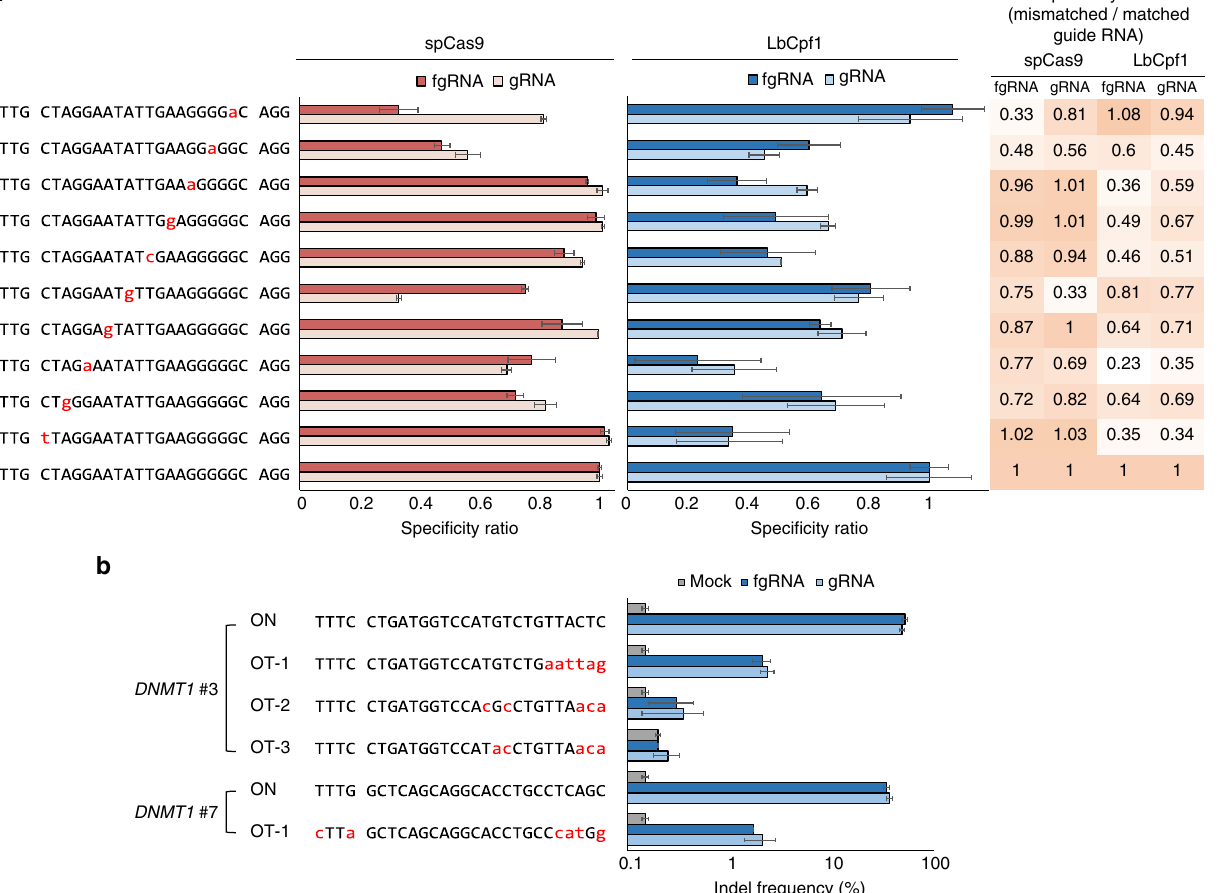
Fig. 2 Comparison of mismatch tolerance of fgRNAs with those of guide RNAs. a Mismatched fgRNAs or gRNAs that differed from human VEGFA target sites by one nucleotide were transfected into HeLa cells. b Comparison of off-target effects between the fgRNAs and conventional gRNAs of LbCpf1. No signi fi cant difference was observed between the two types of guide RNAs at four different potential off-target sites. Mismatched nucleotides are colored in red. Error bars indicate s.e.m. ( n =